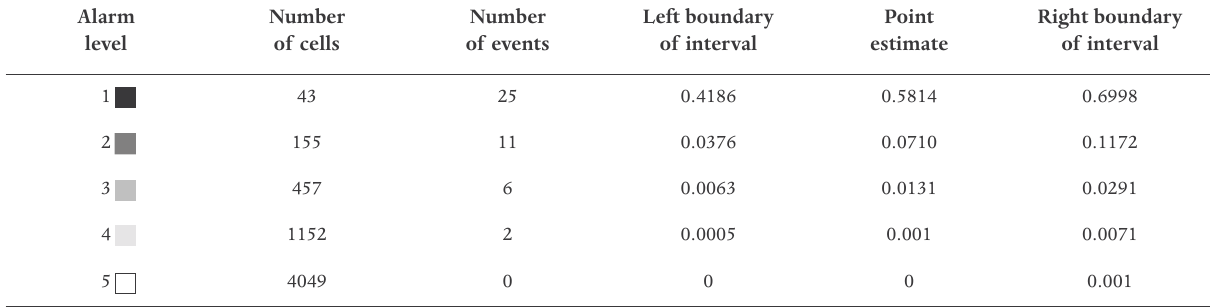
Table 1. Number of events and alarm cells for each level of the retrospective analysis for